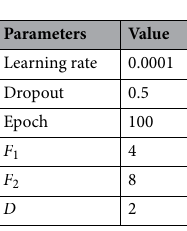
Table 2. The value of each parameter of the model.